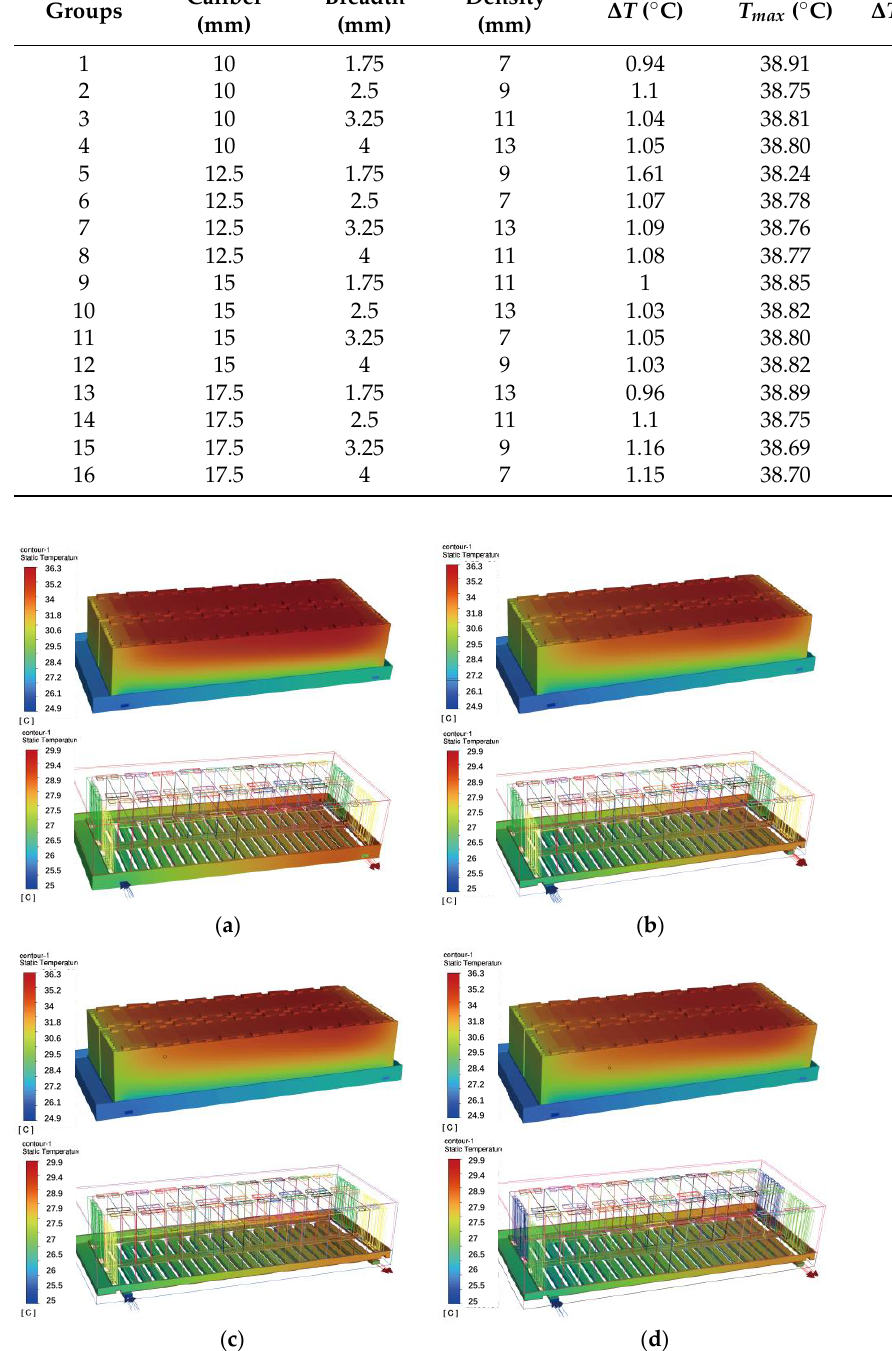
Figure 8 . ( a ) Temperature cloud of the battery pack for group I ( b ) Temperature cloud of the battery pack for group III ( c ) Temperature cloud of the battery pack for group XII ( d ) Temperature cloud of the battery pack for group XVI.